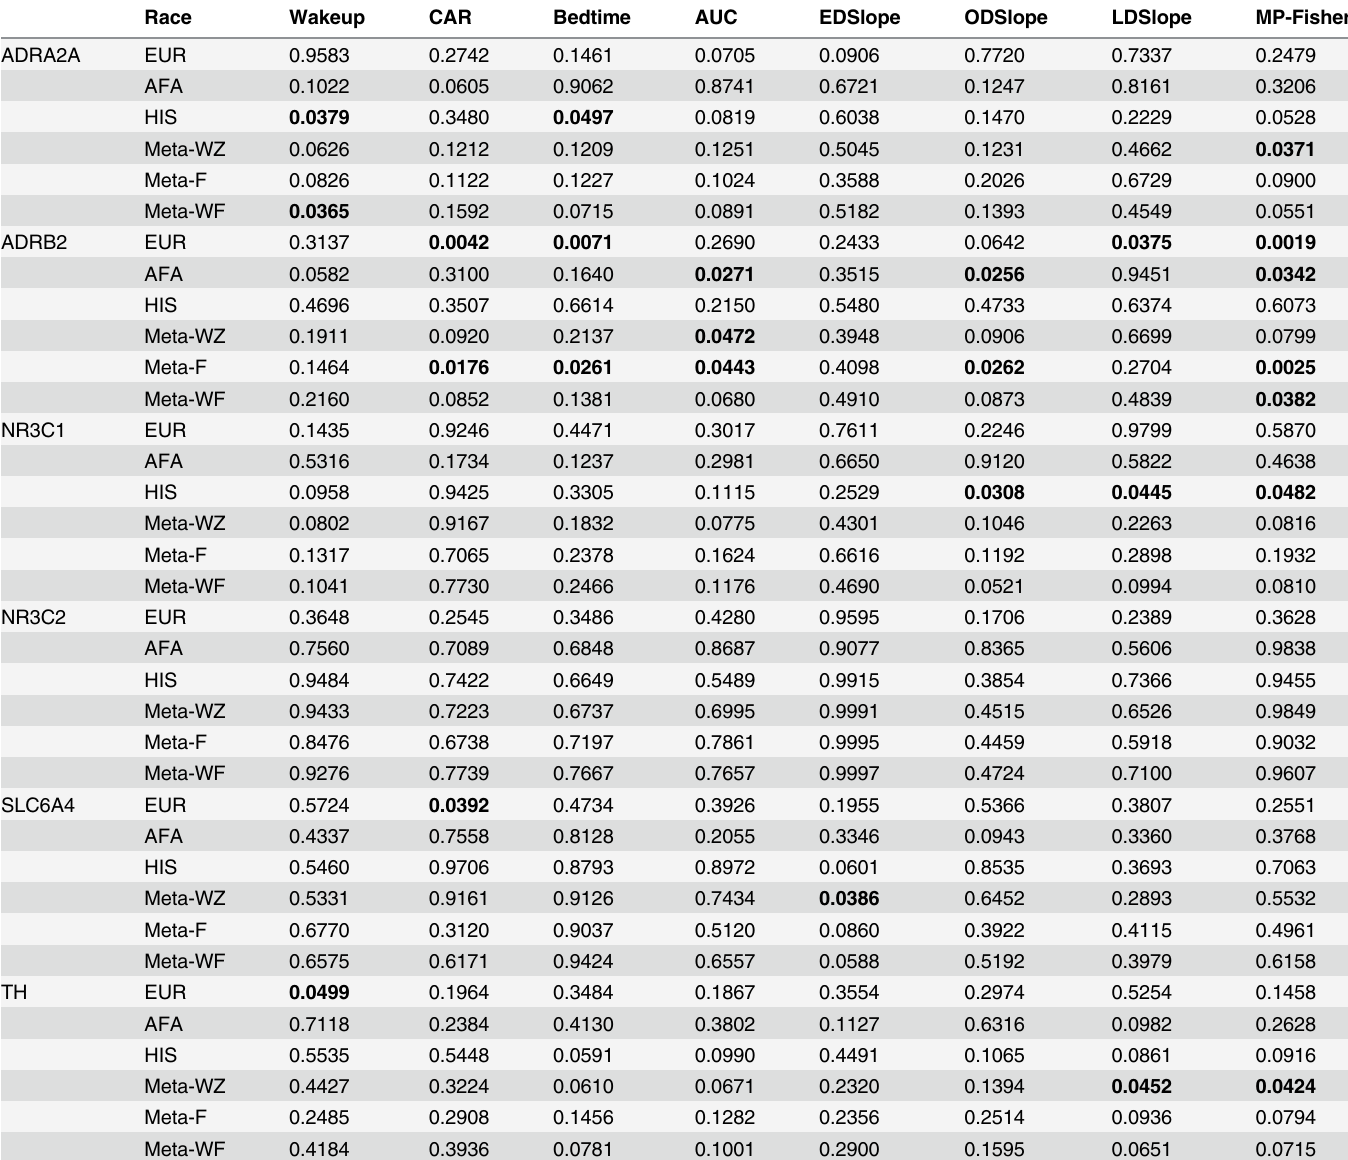
Table 3. Gene based analysis testing the association between the cortisol features and common variants (minor allele frequency > 0.05) in the stress response genes using SKAT (Method